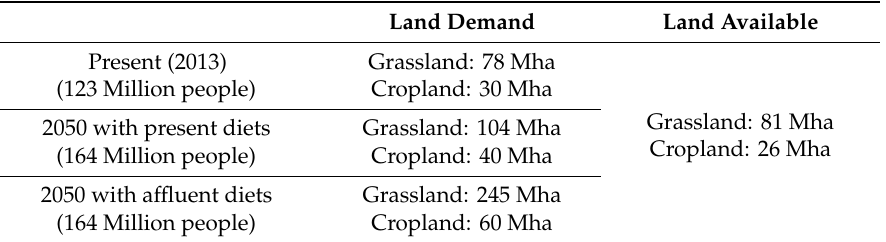
Table 10. Land demand versus Land available. The land available in 2013 and 2050 is assumed to be the same. Source of data: Land demand, calculations by the authors (see text for details); Land available, from FAO [7], data of “Permanent meadows and pastures” for grassland, and “Arable land and permanent crops” for